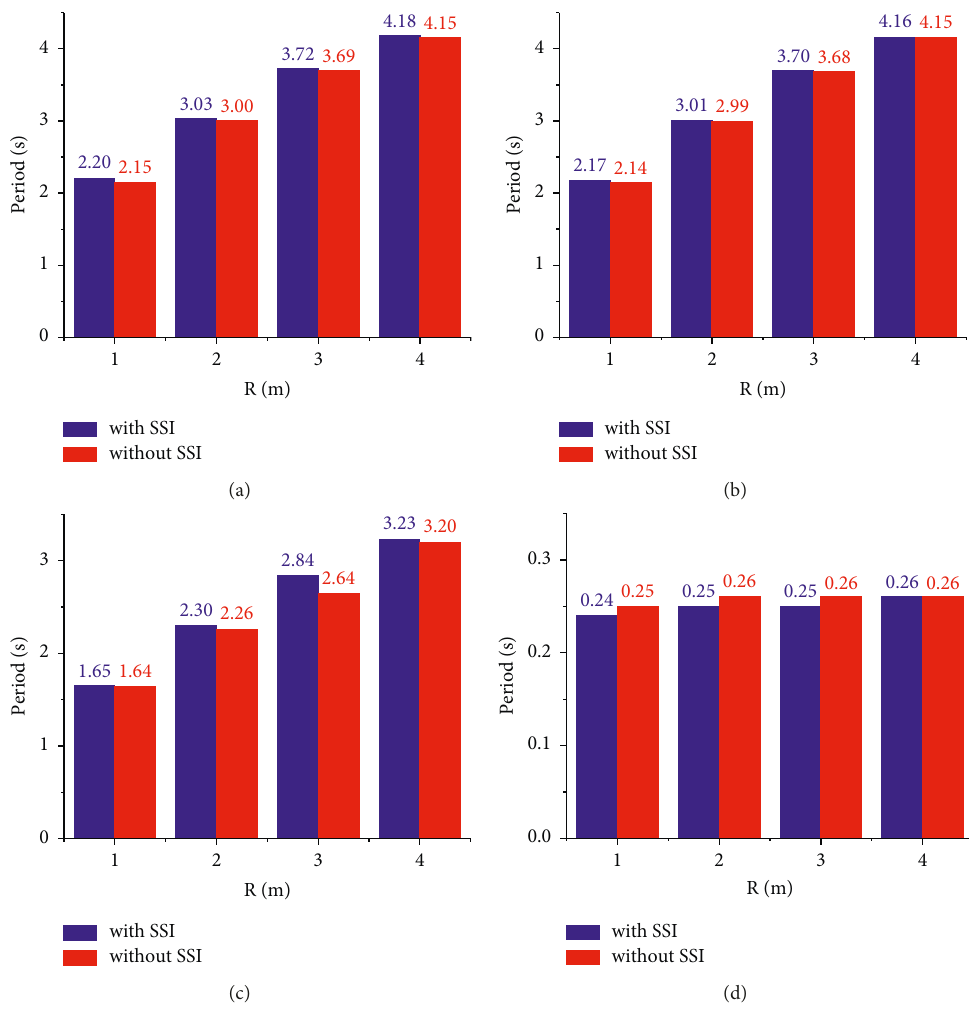
Figure 6: Periods of modes 1 to 4 under different radii of FRS. (a) Mode 1. (b) Mode 2. (c) Mode 3. (d) Mode 4.